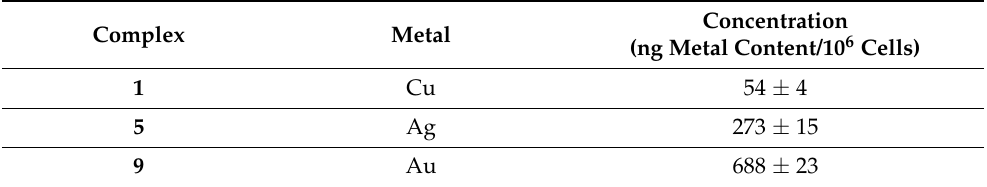
Table 3. Total cellular uptake of OVCAR3 cells treated with complexes 1 (Cu), 5 (Ag), and 9 (Au) using the IC 50 equivalent concentrations of 70 µ M ( 1 , 24 h), 20 µ M ( 5 , 6 h), and 20 µ M ( 9 , 6 h). The results are the mean ± SD values of concentrations expressed in ng (Cu, Ag, or Au)/million OVCAR3 cells. Complex